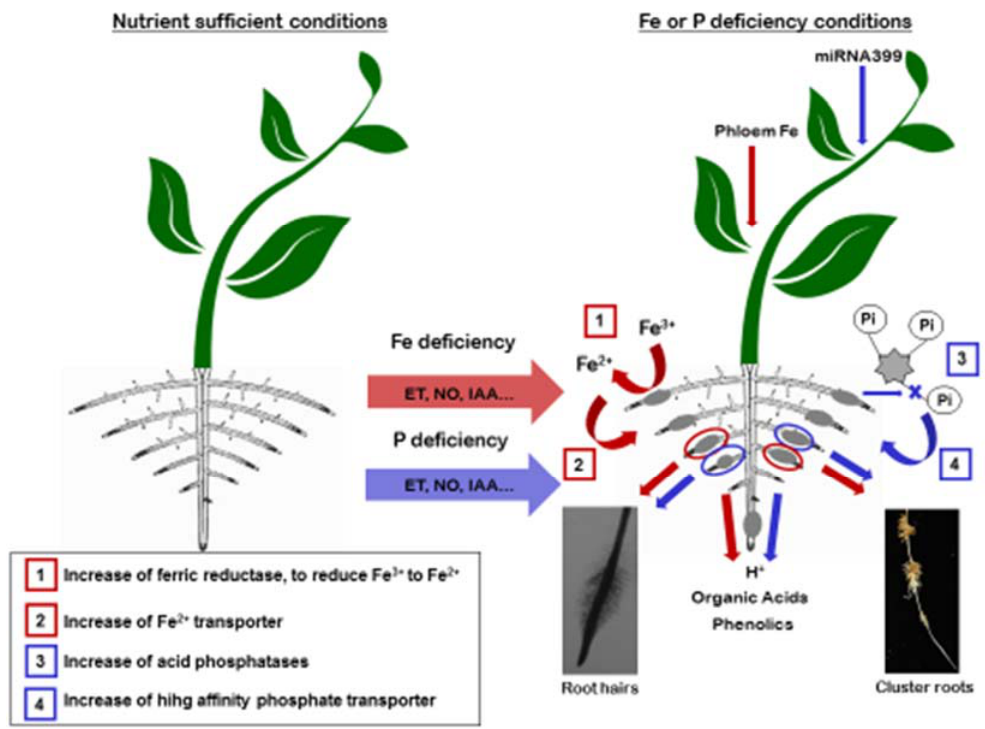
Figure 1. Overview of morphological and physiological responses to Fe ( red arrows ) or P ( blue arrows ) deficiency in dicot plants. The production of ethylene (ET), nitric oxide (NO) and auxin (IAA) is increased by roots of dicot plants under both deficiencies. These hormones up ‐ regulate the expression of genes implicated in physiological and morphological responses to both deficiencies. Under Fe deficiency, dicot plants increase ferric reductase (1) and Fe 2+ uptake through a Fe 2+ transporter (2). Under P deficiency, dicot plants enhance the synthesis and release of acid phosphatases (3) and the P uptake through P transporters (4). Both deficiencies induce the acidification of the extracellular medium and the synthesis and release of organic acids and phenolics. In relation to morphological responses, both deficiencies can activate the formation of subapical root hairs and cluster roots. Besides ethylene, NO and IAA, long distance signals become very important in the regulation of the responses to both deficiencies. Phloem Fe could play a role in the inhibition of the expression of Fe acquisition genes in roots. Similarly, miRNA399, overexpressed under P deficiency, could affect P deficiency responses in roots.